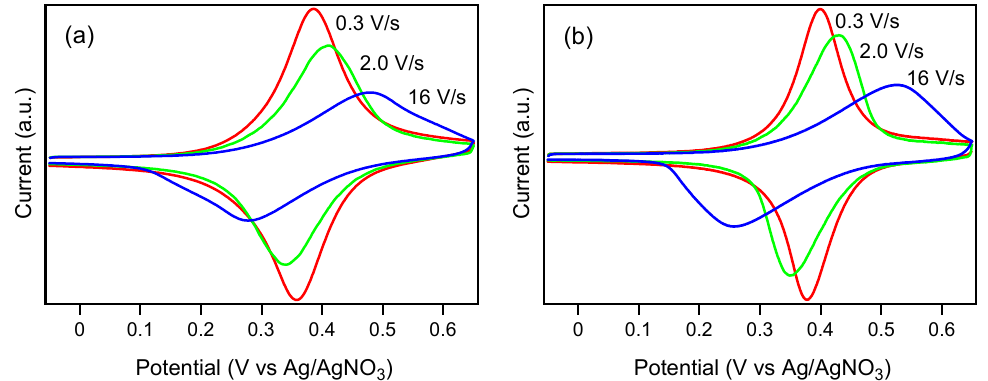
Figure 4. Cyclic voltammograms of the SAM of ( a ) 2a and ( b ) 2b recorded at different scan rates in CH 2 Cl 2 containing 0.1 M TBAP as a supporting electrolyte. The geometric area of the working electrode was 0.152 cm 2 .